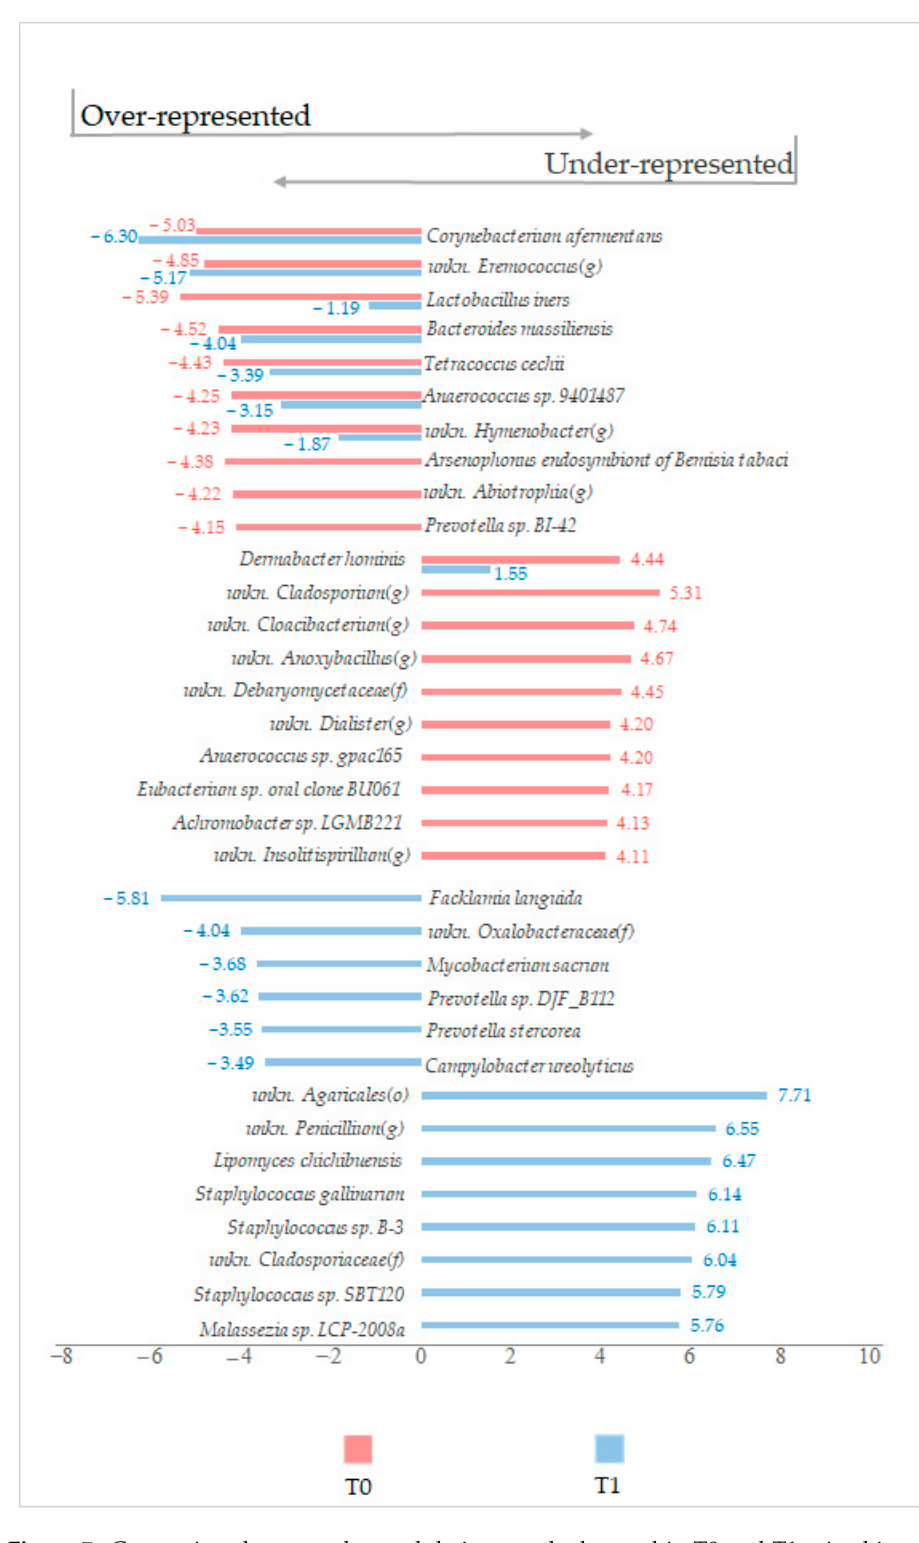
Figure 7. Comparison between the modulation trends detected in T0 and T1 microbiota for the ten most under (bars to the left side) and ten most over (bars to the right side) modulated OTUs.